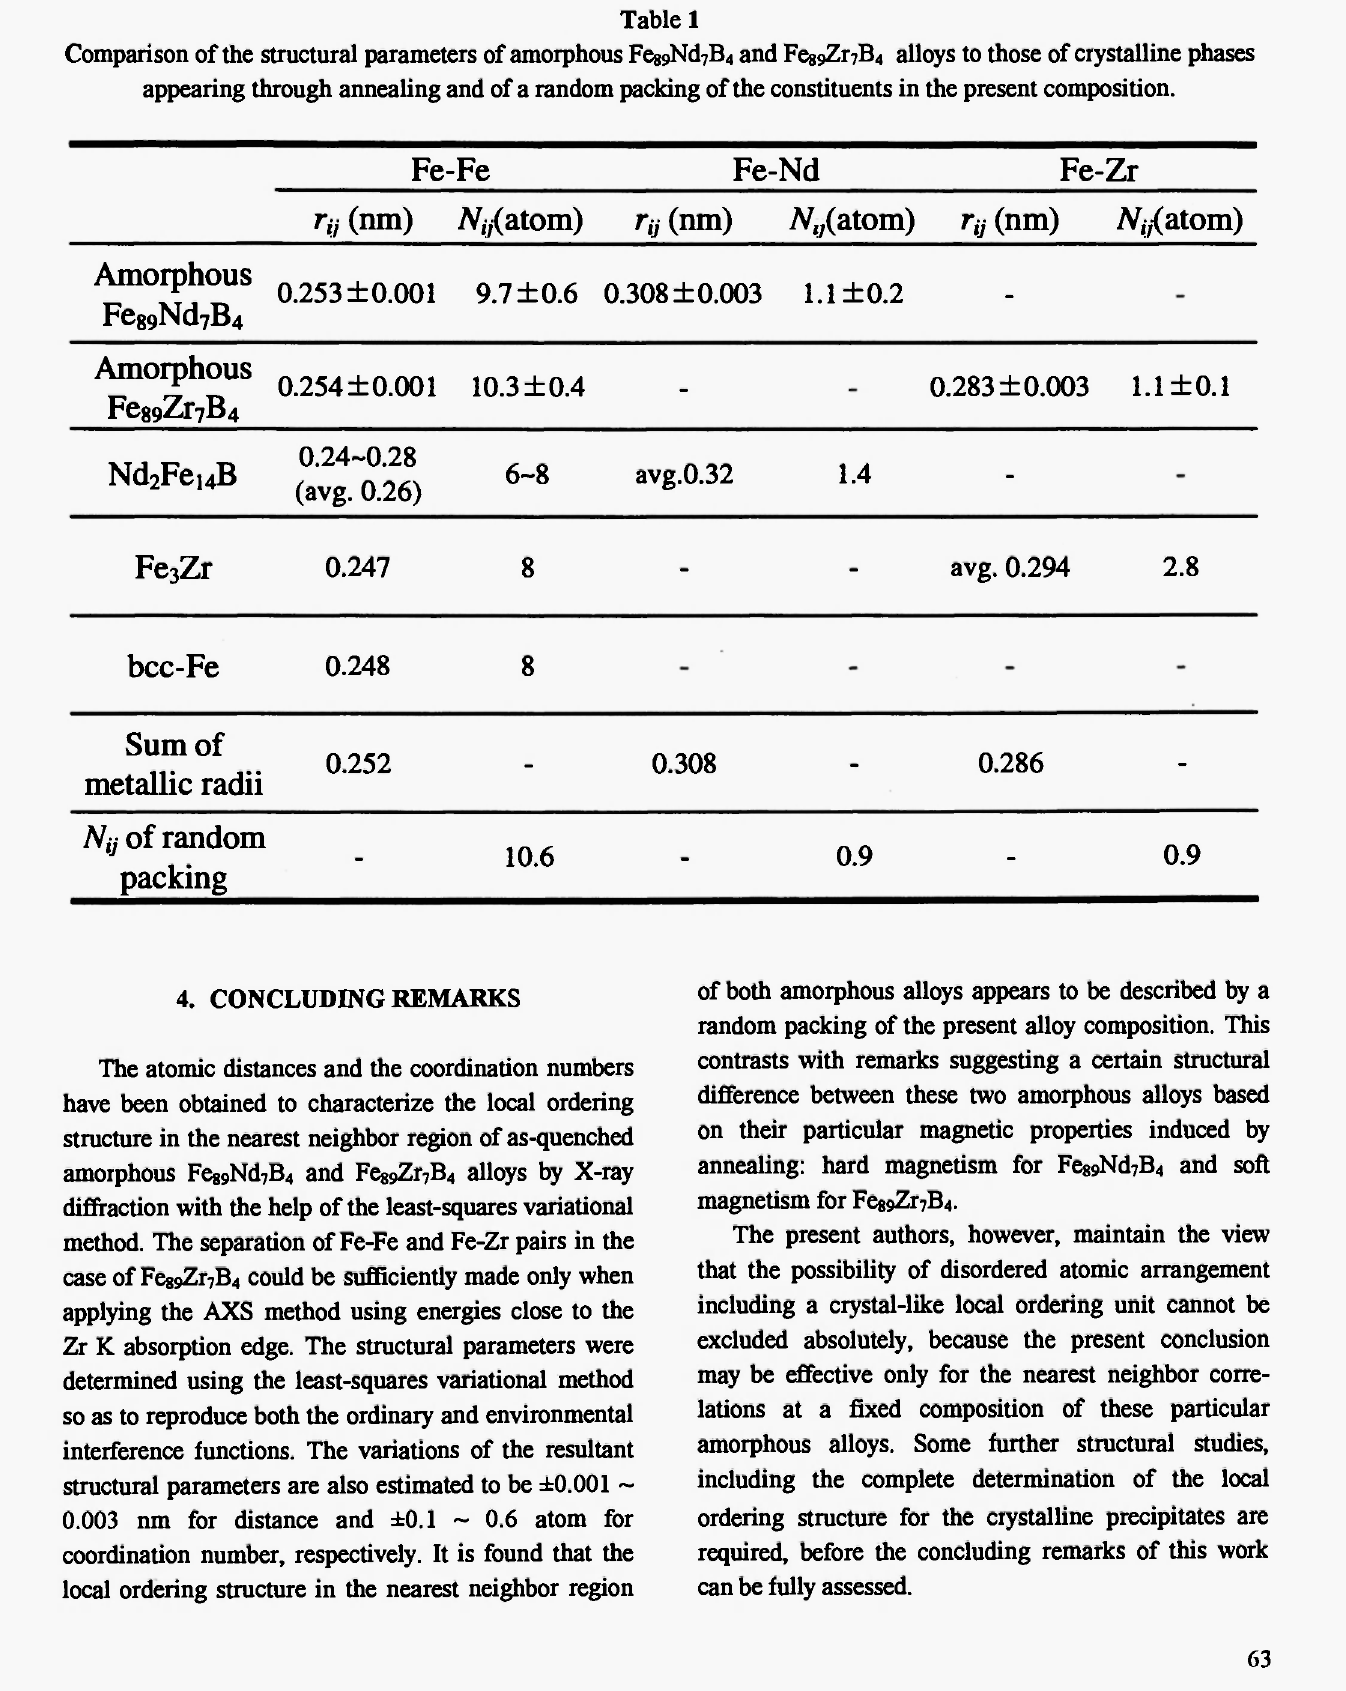
Comparison of the structural parameters of amorphous Fe89Nd appearing through annealing and of a random packing of the constituents in the present